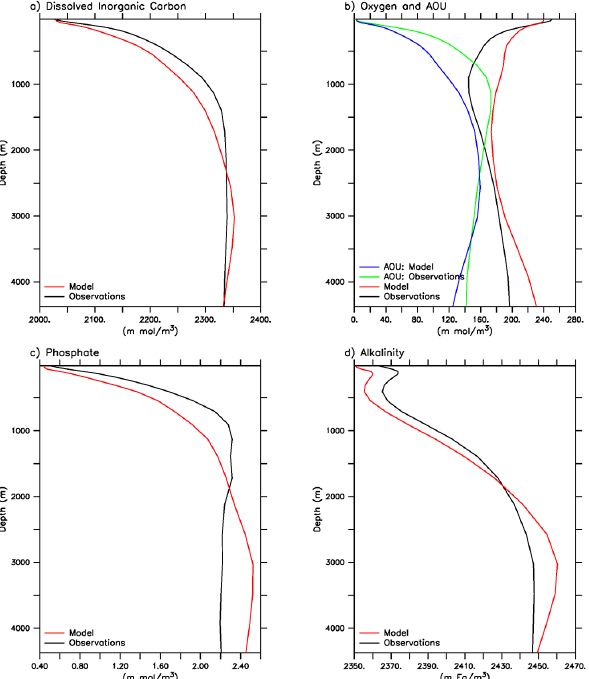
Figure A2. Comparison of the global averaged profiles of the REF simulation in the year 1850 with the observations for (a) preindus- trial dissolved inorganic carbon; (b) dissolved oxygen and appar- ent oxygen utilisation; (c) phosphate and (d) alkalinity in units of mmolm − 3 . The observed fields come from (Key et al., 2004) and (Boyer et al.,